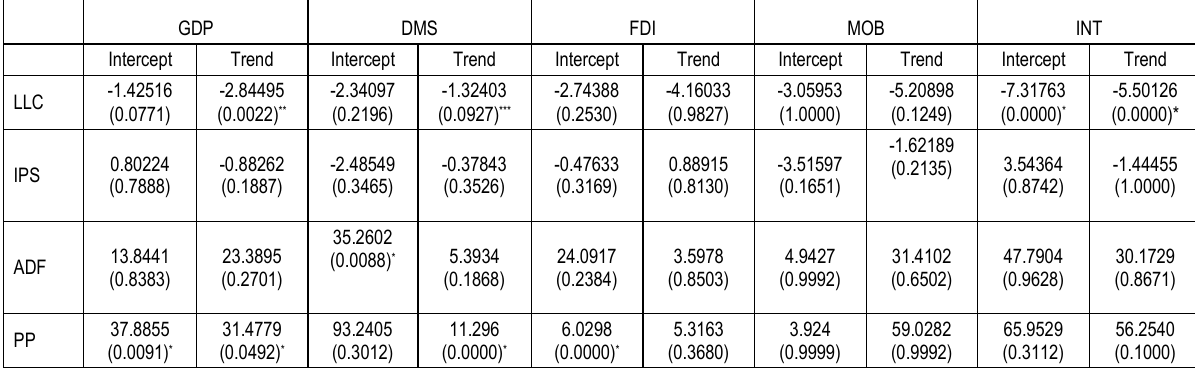
Table 2. Panel unit root tests results: series in level